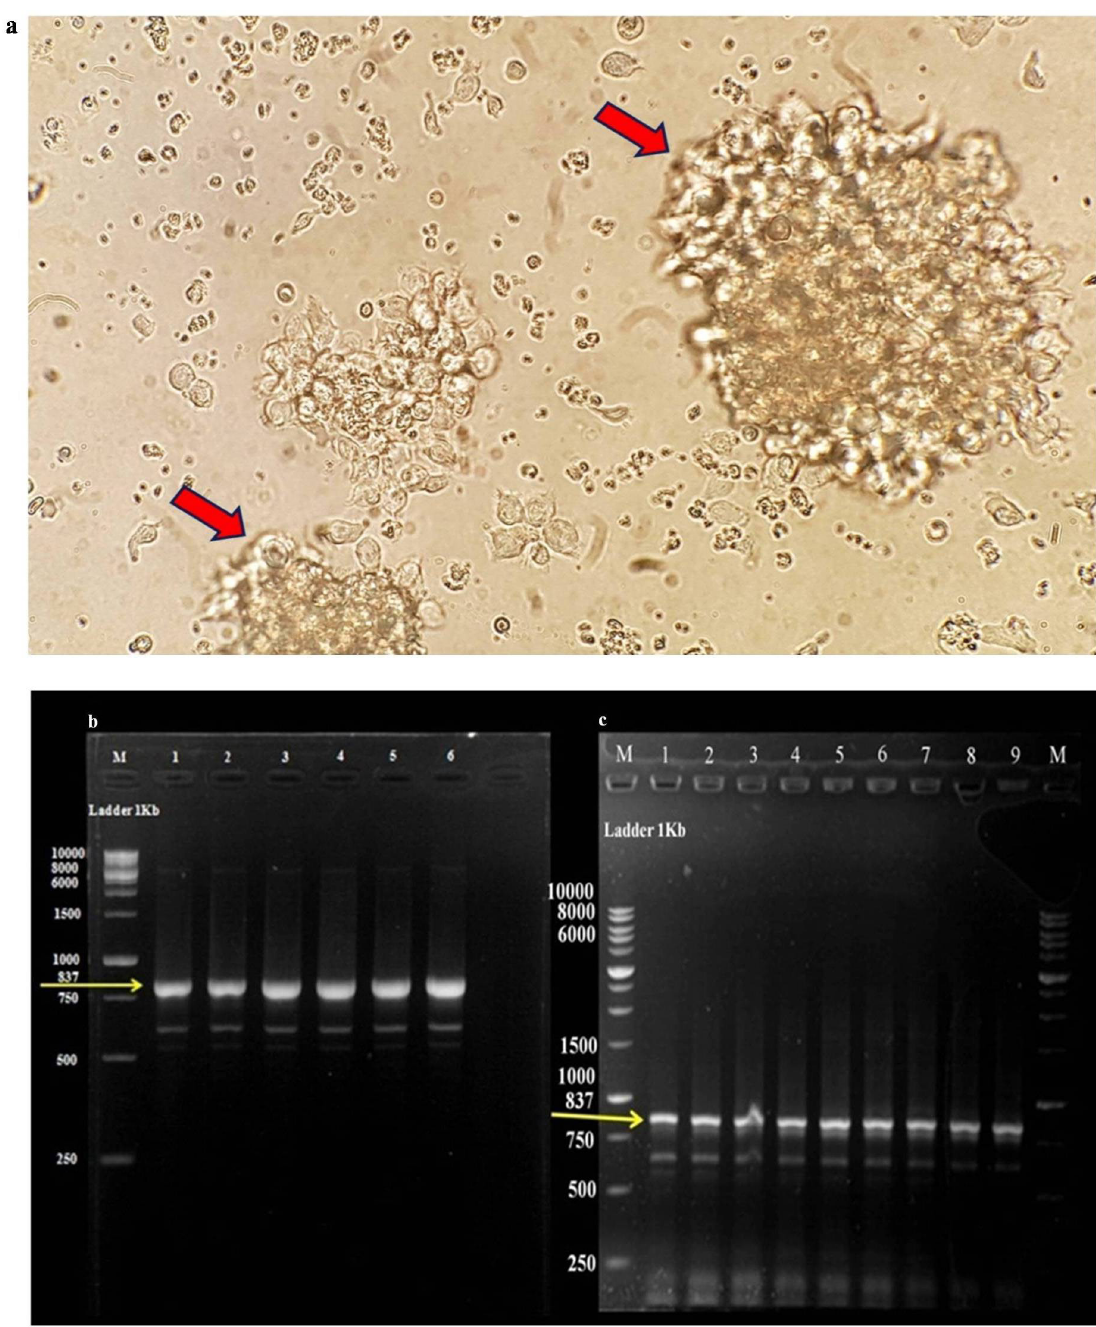
Figure 2: (a) PHA-stimulated blasts of PBMCs were cultured 72h and observed by XDS-1 inverted microscope (25X) (Chongqing COIC Industrial Co., China). The blasts of PBMCs were marked by two red arrows. (b) First round-PCR containing cDNAs as the templates. The wells of 1 to 6 were amplified in the annealing temperatures of 55.6, 56.8, 58.1, 59.5, 60, 62.1°C, respectively. There were no great differences among the amplified PCR products due to the different annealing temperatures. (c) Second round-PCR containing first round-PCR products as the templates. The wells of 1 to 9 were amplified in the annealing temperatures of 60, 61.6, 62.8, 64.1, 65.5, 66.9, 68.1, 69.2, 70.5°C respectively. There were no great differences among the amplified PCR products due to the different annealing temperatures. In both agarose gels, the wells were marked by “M” referred to GeneRuler 1Kb DNA Ladder (Cat No. SM0311, Thermo Fisher Scientific Inc., MA, USA). Also, the wells were marked by the numbers referred to the same reactions in the different annealing temperature by gradient